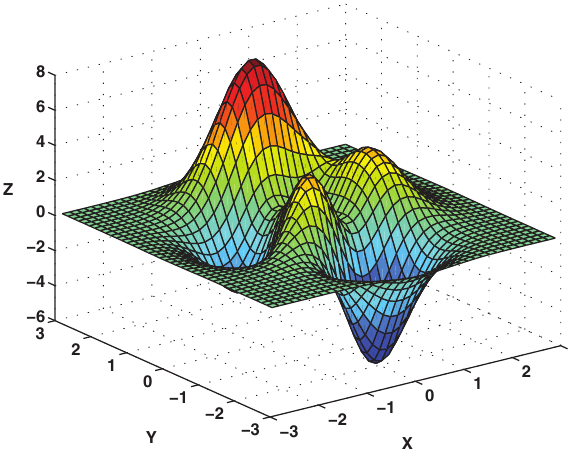
Figure 2. Graphical representation of the surface used for the 3D maximization problem. Visualized in MATLAB 6.5 Using the Command peaks(40). The three maximums of the surface were located at f = 8.1165 (global maximum), 3.5507, and